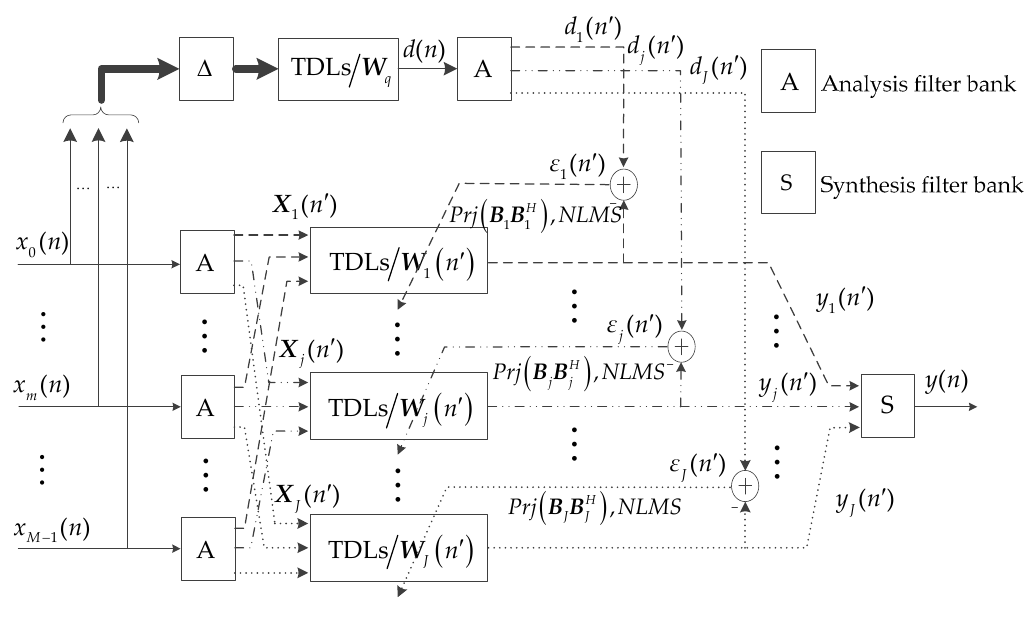
Figure 7. Schematic diagram of the proposed SBB.